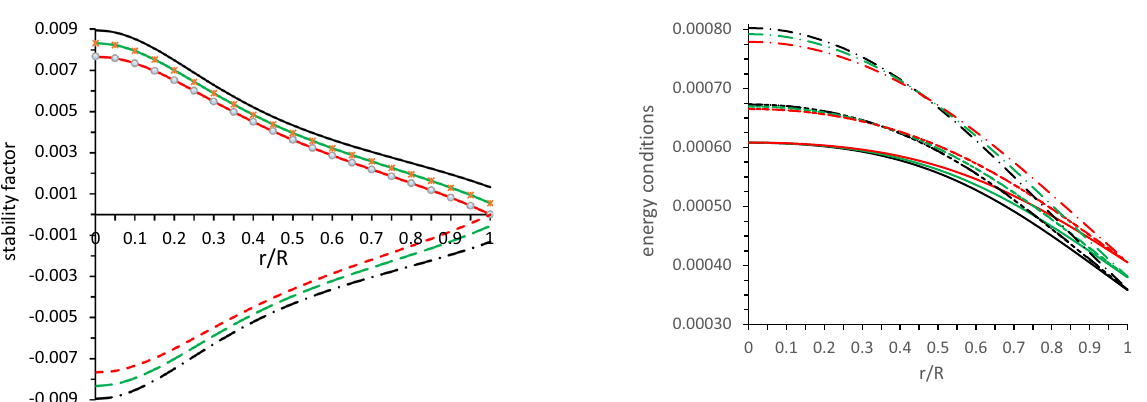
Fig. 7 The behavior of energy condition verses radial coordinate r / R . The description of the figures as follows: the solid line for ρ tot , dotted line for ρ tot + p tot r , small dashed lines for ρ tot + p tot t , and long dashed- dotted lines for ρ tot + p tot t + 2 p tot t for different compact objects PSR J1614-2230 (black color), 4U1608-52 (green color), and Cen X-3 (red